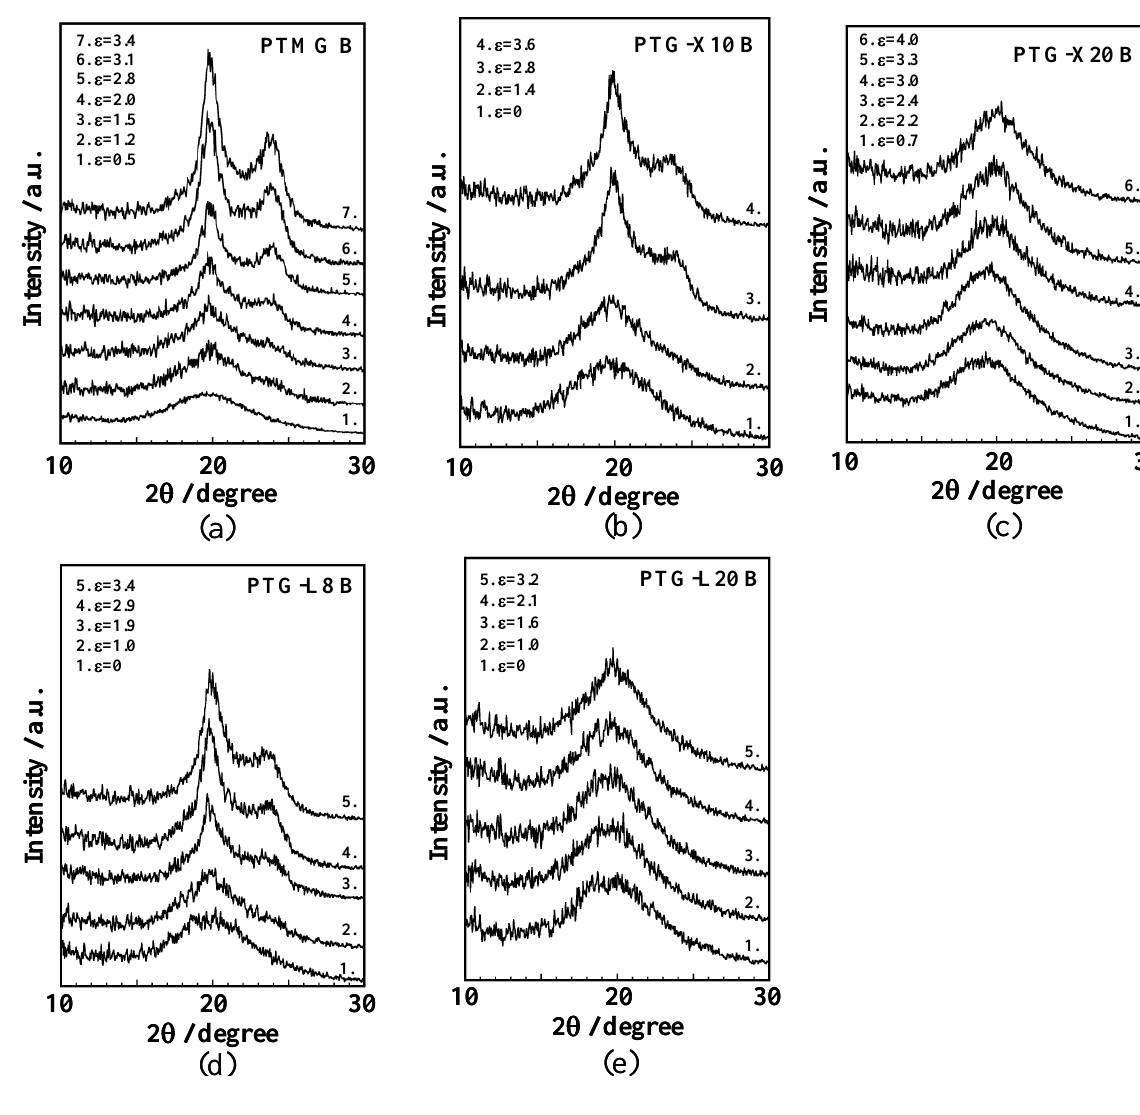
Figure 5. WAXD profiles of ( a ) PTMG B, ( b ) PTG-X10 B, ( c ) PTG-X20